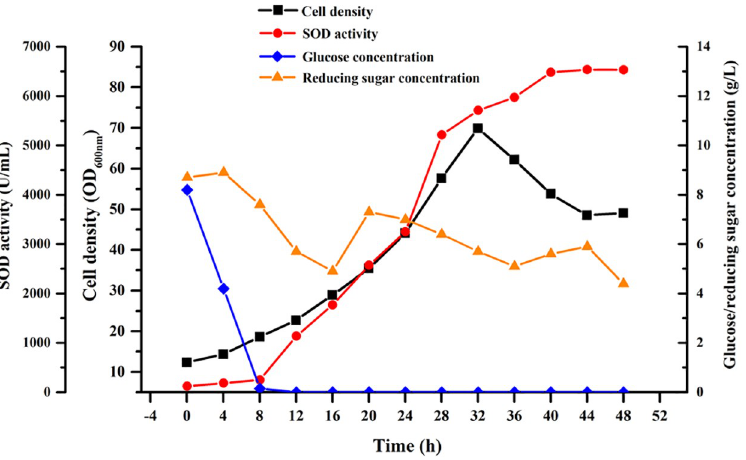
Fig 3. Time courses of cell growth, sugar concentrations, and SOD activity in batch fermentation by recombinant B . subtilis expressing Aa SOD in a 10 L stirred